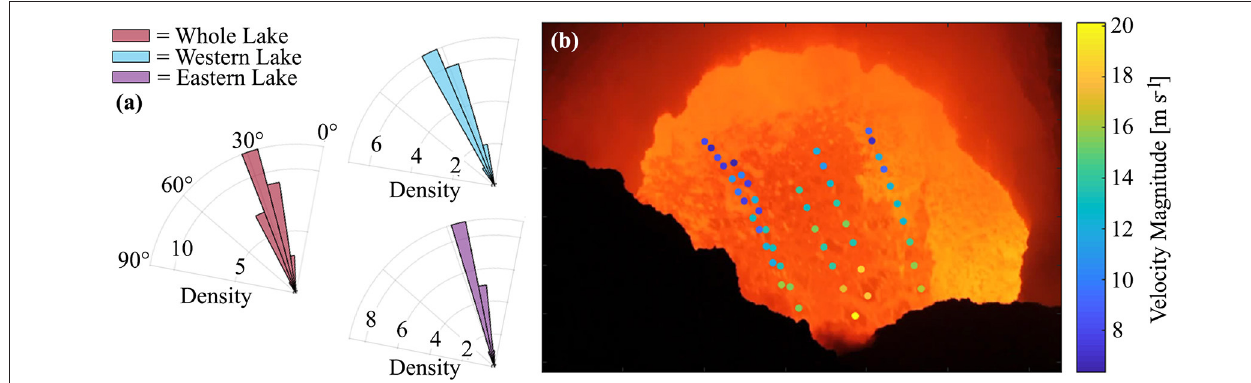
FIGURE 6 | (A) the distribution of bubble burst diameters on the lake surface, (B) the number of bursts in 5s bins, (C) the mass of each bubble burst through time, and (D) bubble mass emission rate with a superimposed savitzy golay filter of 1min.